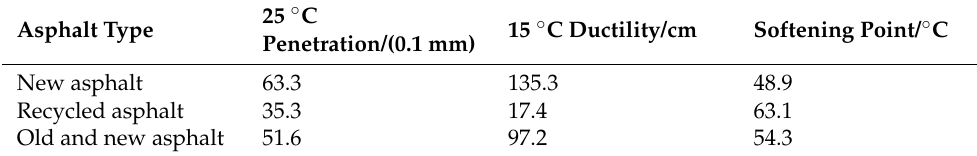
Table 1. Technical indexes of the matrix asphalt and recycled